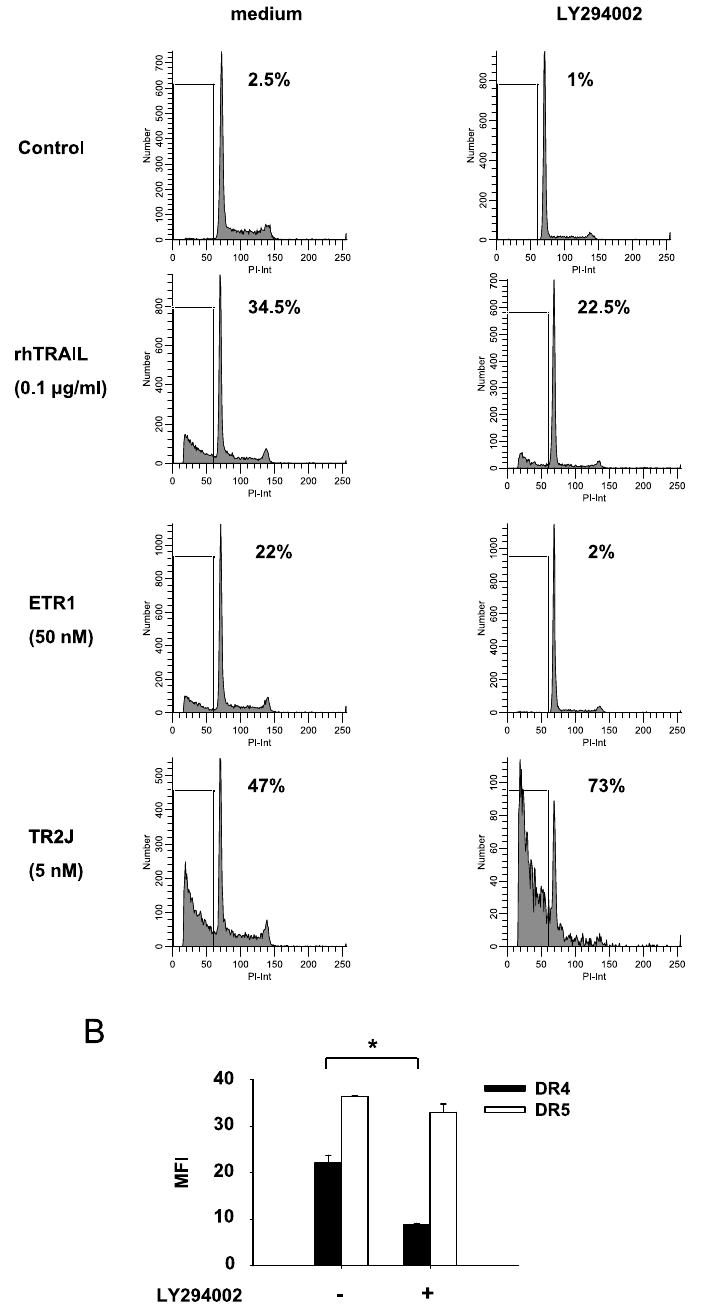
Fig. 5. The effects of PI3K inhibition on DR-mediated apoptosis can also be seen in cells that are already more sensitive to HGS-TR2J than to HGS-ETR1 initially. (A) Sub-G1 content analysis in Colo205. Cells were pre-incubated for 15–18 h with 20 µM LY294002, then either left untreated or exposed to rhTRAIL (0.1 µg/ml), HGS-ETR1 (50 nM) or HGS-TR2J (50 nM) for 3 additional hours before harvest. Nuclear DNA was then stained with propidium iodide and the cells analyzed by flow cytometry. The value in percent indicates the amount of apoptosis as measured by the count of sub-G1 events. One representative of at least 3 independent experiments is shown. (B) Surface expression of TRAIL receptors in Colo205, in untreated cells and after 15–18 h exposure to 20 µM LY294002. Receptor expression is measured as Mean Fluorescent Intensity (MFI) normalized to